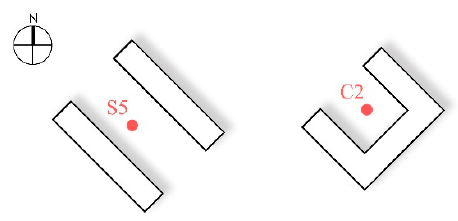
Figure 8. Monitoring sites of the courtyard and street with the same SVF and green coverage ratios.